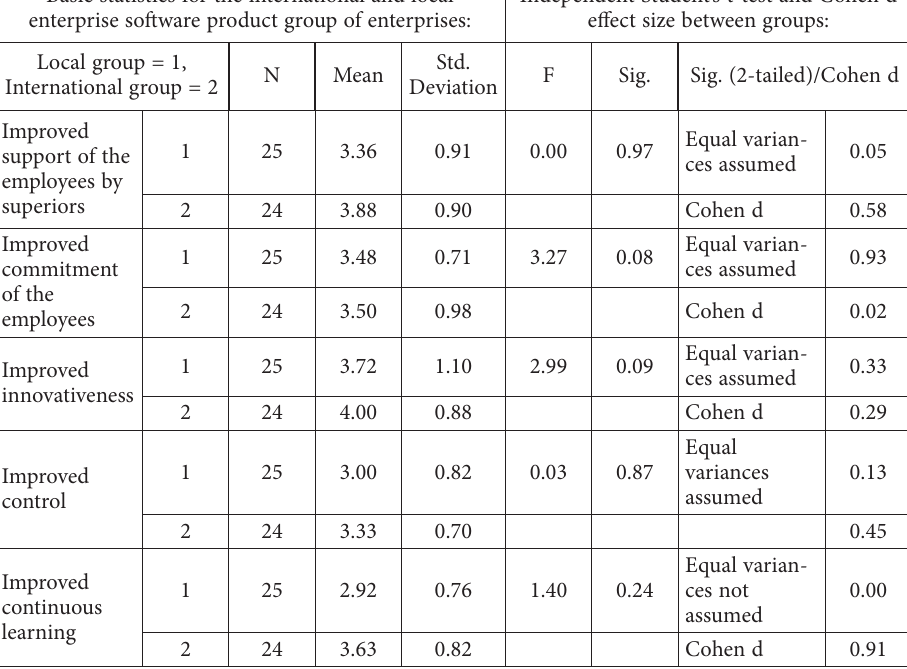
Table 2. The comparison of cultural characteristics from Table 1 between the enterprises that predomi- nantly invest in international enterprise software products and those that predominantly invest in local enterprise software products Basic statistics for the international and local Independent Student’s t-test and Cohen d enterprise software product group of enterprises: effect size between groups: Local group = 1, Std. N Mean International group = 2 Deviation